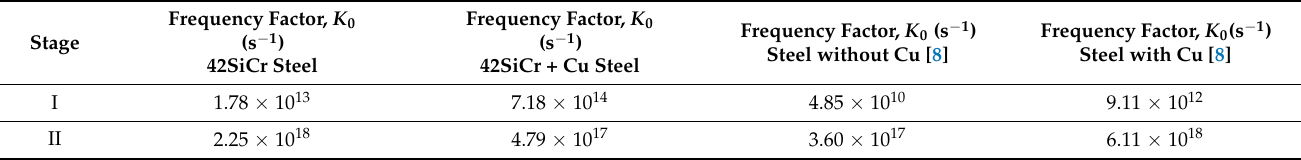
Table 5. Parameter K 0 calculated for 42SiCr and 42SiCr + Cu steels and its comparison with steels without and with Cu [7,8], using Equation